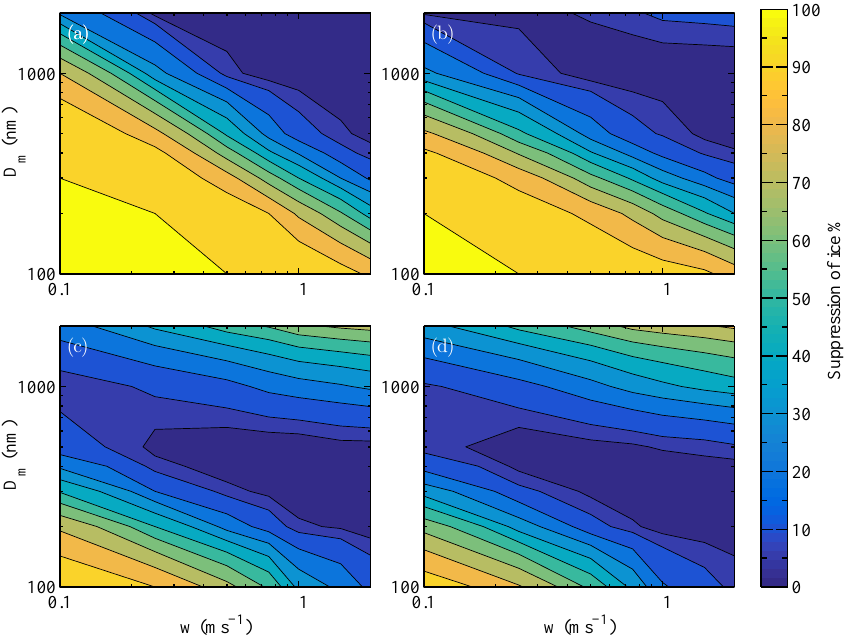
Figure 4. Results from 196 pairs of “low CCN” and “high CCN” model simulations with initial conditions as detailed in Tables 2 and 3. For each of the four soluble fractions of INP the updraft velocity ranged between 0.1 and 2 ms − 1 and the diameter of the INP varied between 100 and 2000nm. The ice crystal number concentration in every simulation was taken at − 30 ◦ C. Contours show the percentage less ice that formed in the “high CCN” case compared to the “low CCN” case. The criteria for heterogeneous freezing in these results is that only activated drops can